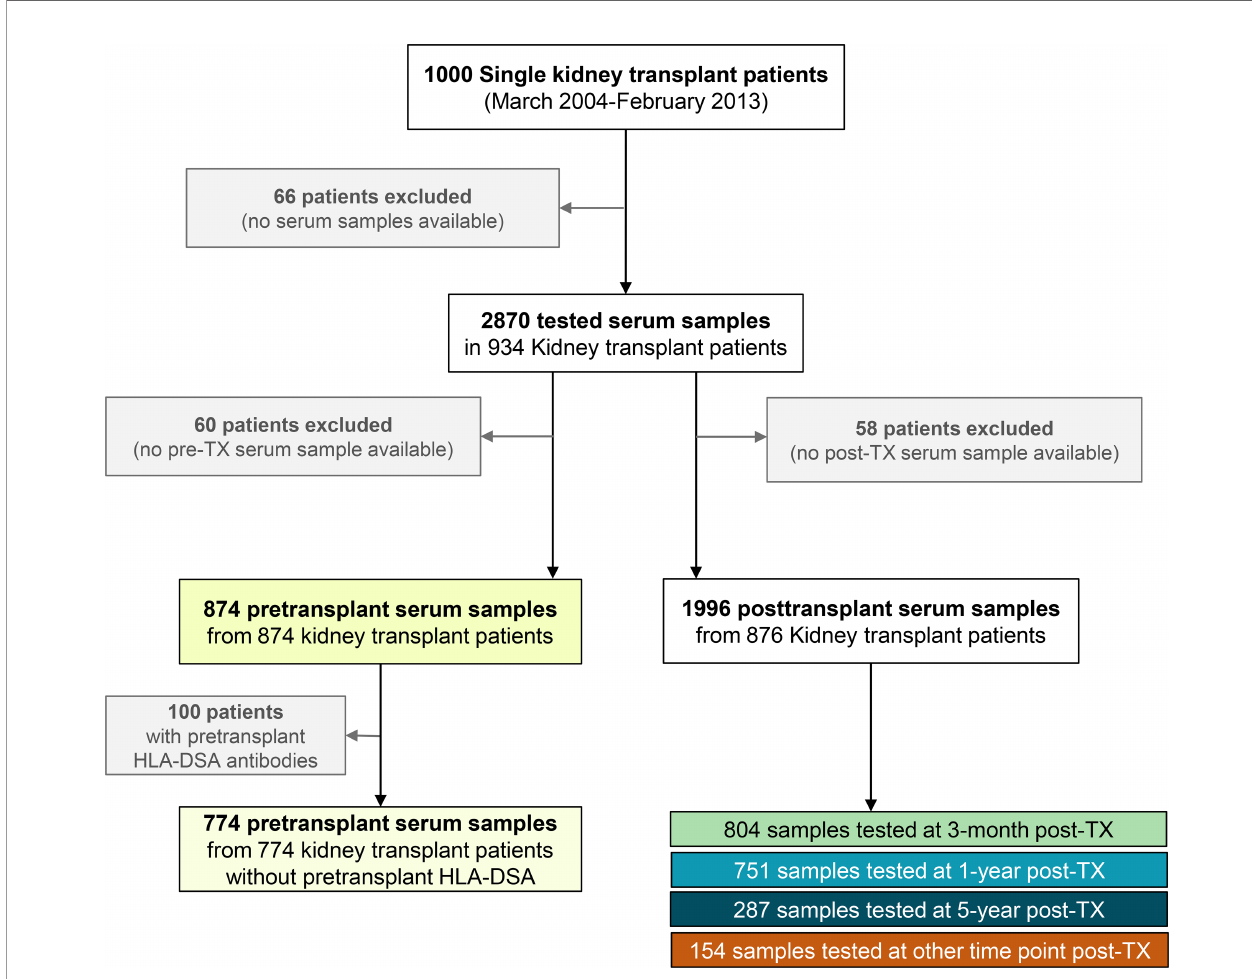
FIGURE 1 | Flow chart for patient enrollment and study design. Of the 934 kidney transplant patients included in this study, 874 patients had a pretransplant serum sample and 876 patients had at least one post-transplant serum sample available for non-HLA